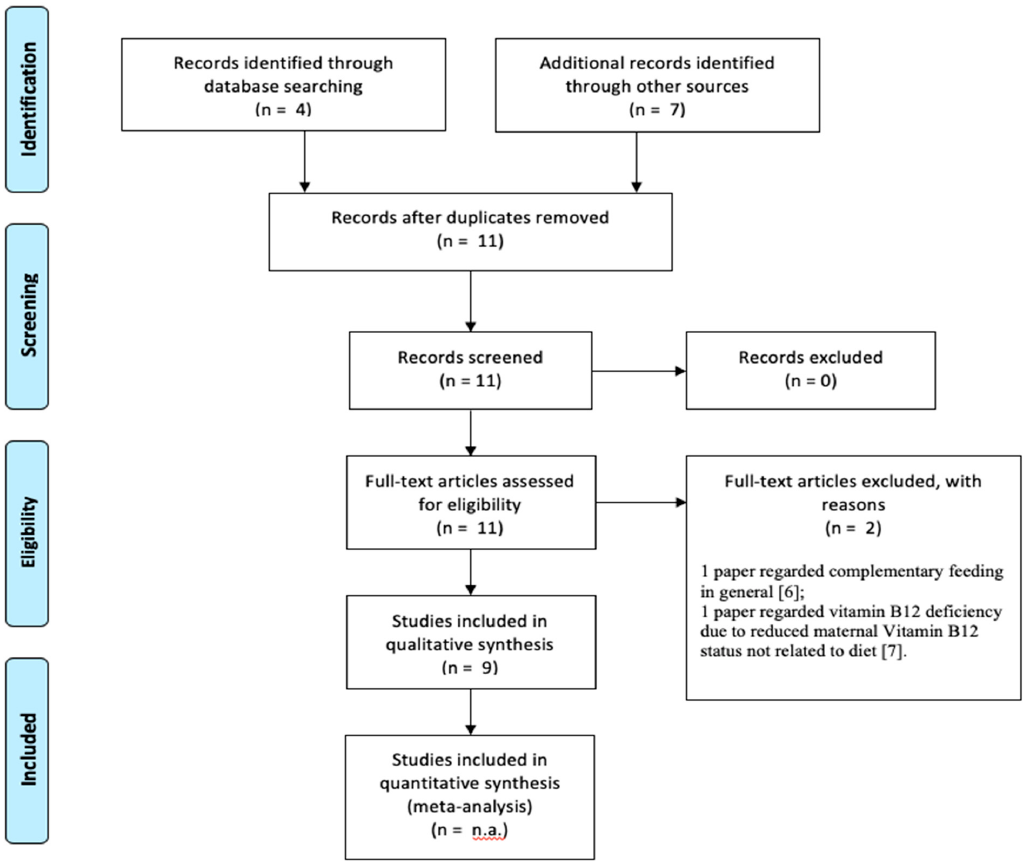
Figure 1. Study selection according to PRISMA guidelines.